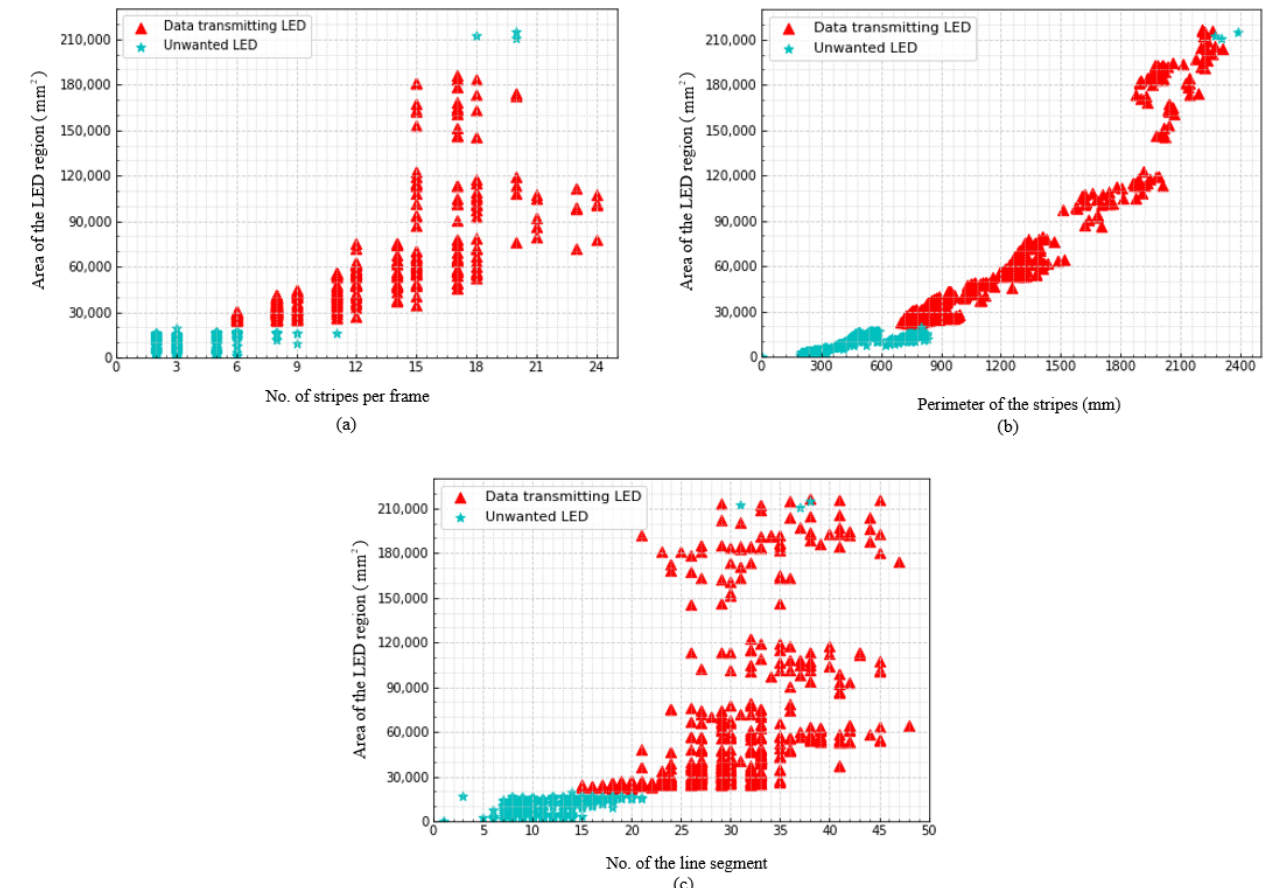
Figure 7. Scatter plot of selected features ( a ) area vs. no. of stripes per LED region; ( b ) area vs. perimeter of the combined stripes contour; and ( c ) area vs. no. of the line segment of the combined stripes